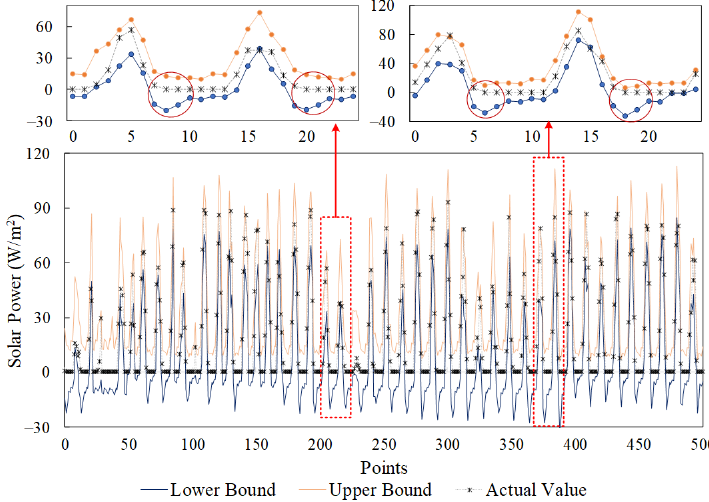
Energies 2019 , 12 , x FOR PEER REVIEW 10 of 18 Figure 5. The prediction results obtained by PSO and PI with ELM-AE. Figure 5. The prediction results obtained by PSO and PI with ELM-AE. Figure 5. The prediction results obtained by PSO and PI with ELM-AE.